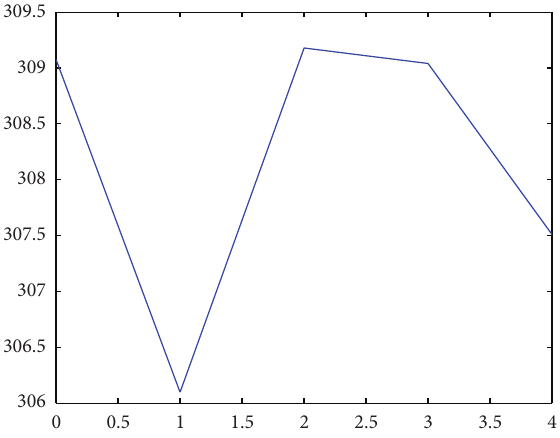
Figure 4: Residual sum function of squares change with the delay.